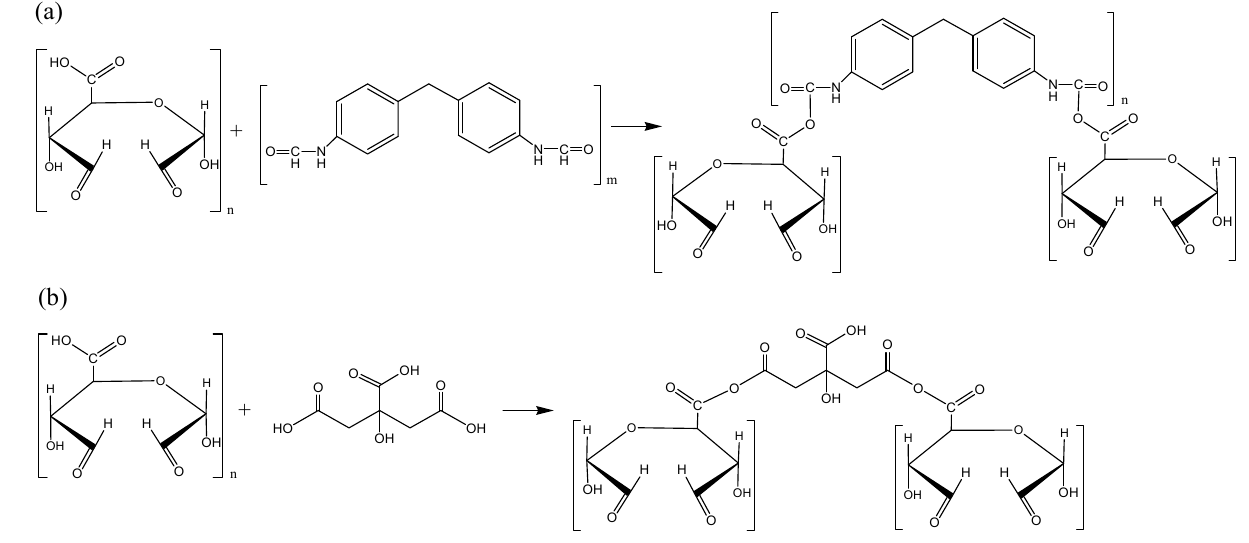
Figure 7. Possible cross-linking reactions of ( a ) B-pMDI/OS and ( b ) CA/OS [56]. An oxidation-gelatinization technique was used to synthesize a cornstarch adhesive, after which its rheological characteristics were determined [112,113]. The apparent viscosity was determined by shear rate, starch-to-water ratio, and temperature. It was found that apparent viscosity reaches a peak value at 10 °C, and then decreases at higher temperatures, increasing shear rate from 6–60 RPM, causing a slight decrease in viscosity. The starch adhesive has fluid-like, pseudo-plastic characteristics. Oxidized starches typically react responsively to heat, turning yellow or brown when subjected to high temperatures. The aldehyde content has been linked to this drying tendency to turn yellow. The oxidized starch in storage turns yellower with increasing aldehyde content. The yellowing of oxidized starch dispersed in water by cooking or alkali is also related to aldehyde